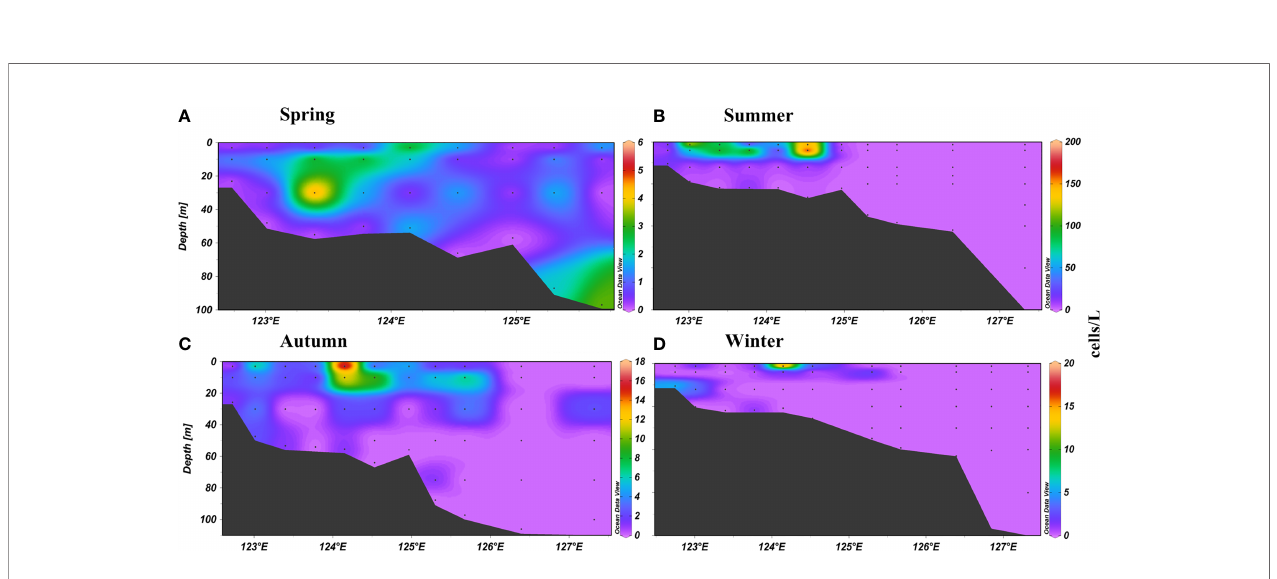
FIGURE 4 | Horizontal distribution of log-transformed (C d +1) of N. scintillans (cells/m 2 ) in the East China Sea and southern Yellow Sea using net-collection method.